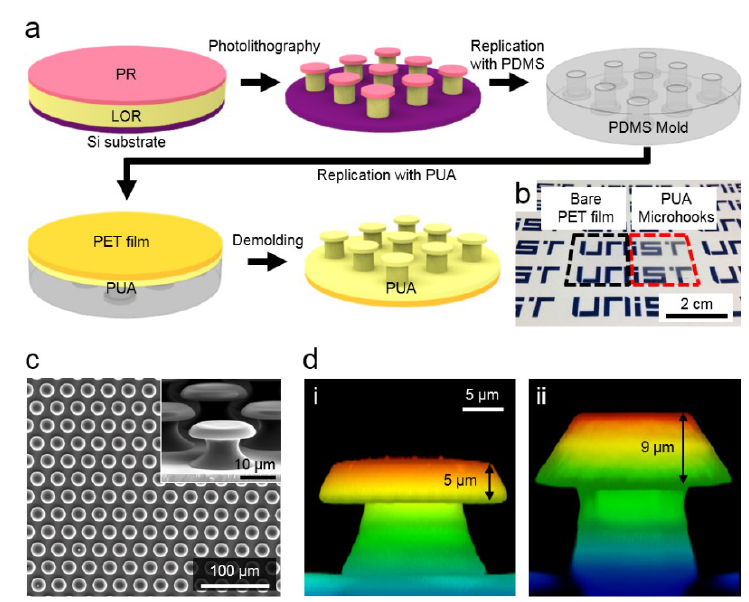
Figure 1. ( a ) Schematic procedure of the fabrication of the 3D microstructure array; ( b ) Photograph of the fabricated microstructure array; ( c ) Top-view and titled scanning electron microscope images of the fabricated microstructure array; ( d ) Confocal microscope images of the microstructures with different tip thicknesses of (i) 5 μm and (ii) 9 μm.